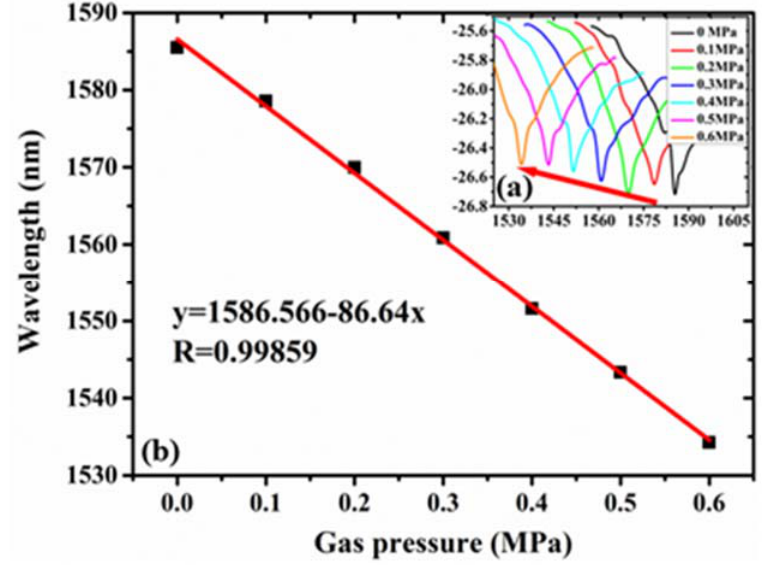
Figure 8. ( a ) Shifts of envelope for sensor 4 under different pressures; ( b ) wavelength versus gas pressure and the fitted line.